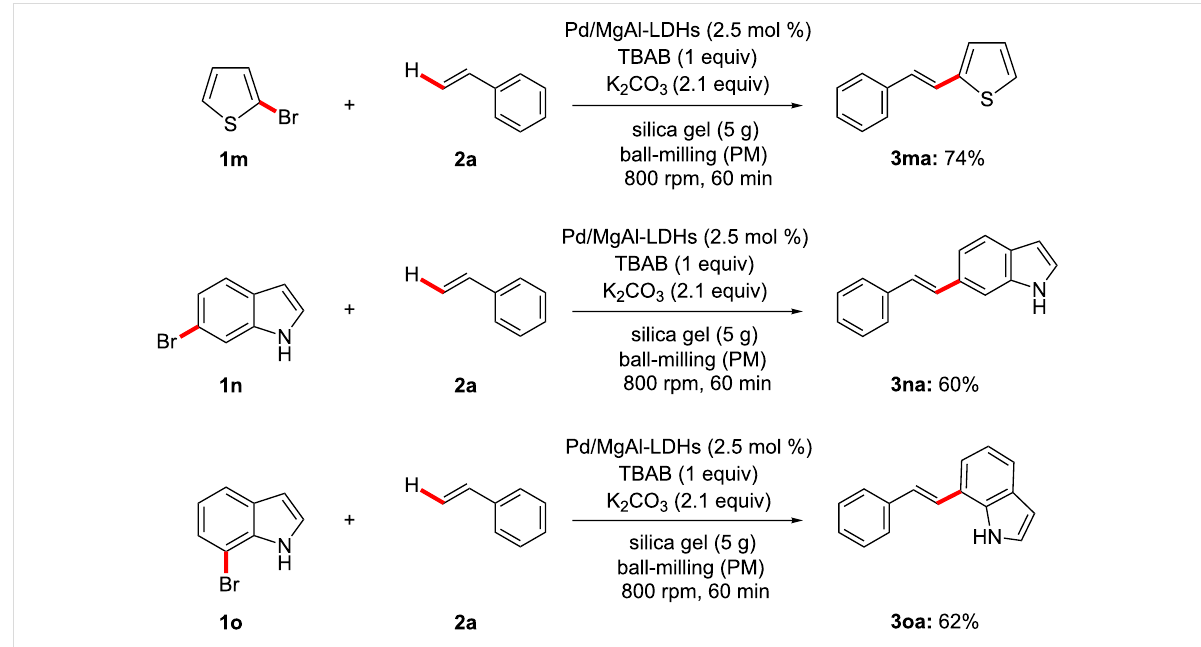
Scheme 3: Pd/MgAl-LDHs catalyzed Heck reactions of heteroaryl bromides. Reaction conditions unless otherwise noted: 1a (1.5 mmol), 2a (2.1 mmol), Pd/MgAl-LDHs (2.5 mol %), TBAB (1.5 mmol), K 2 CO 3 (3.6 mmol), and 5 g silica gel were placed in a 80 mL stainless-steel vessel